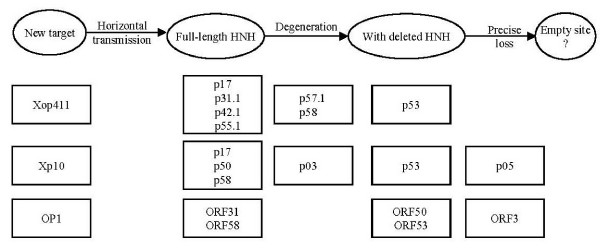
Linear gains and losses of HNN-AP2 endonuclease genes in the three Xoo phages. The boxes contain the possible proteins at different stages of degeneration.